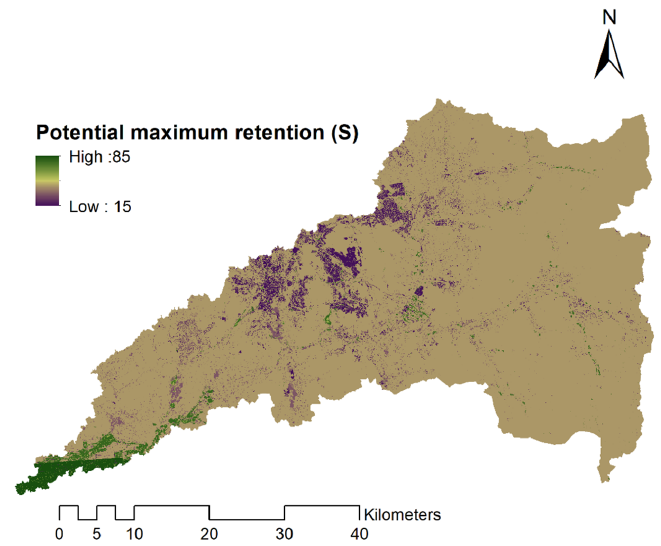
Figure 12. Potential maximum retention (S) map of the study area.